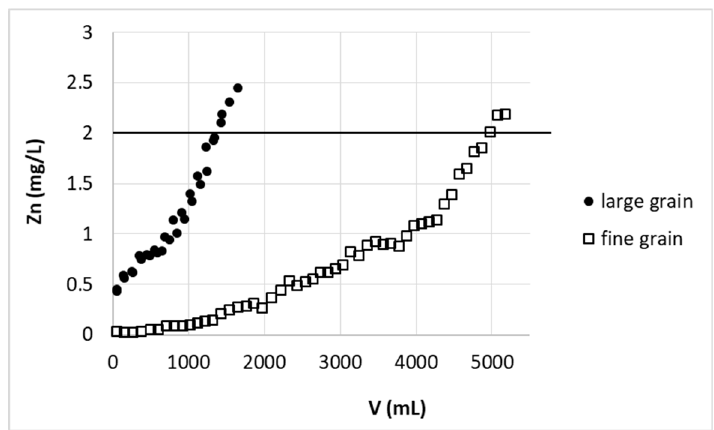
Figure 6. Effect of grain size on zinc(II) ions removal on hybrid pectin-based biosorbent. Mass of sorbent (dry form): small grain 4 g (11.2 cm), large grain 5 g (11.2 cm); flow rate: 60 mL/h; initial concentration of Zn: 30 mg/L; pH = 6.